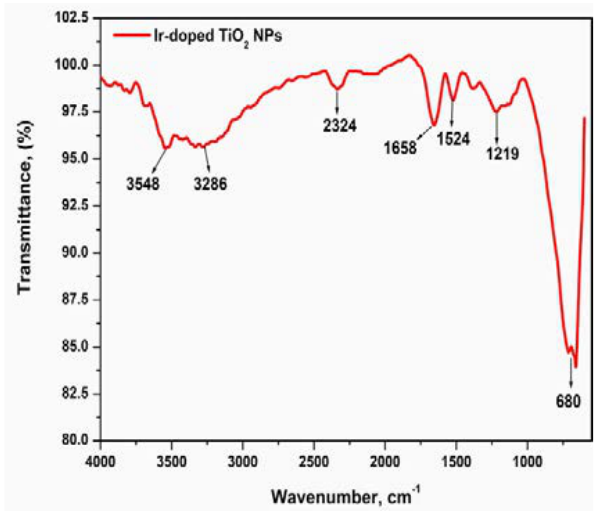
Fig. 3: The FTIR spectrum of Ir-doped TiO